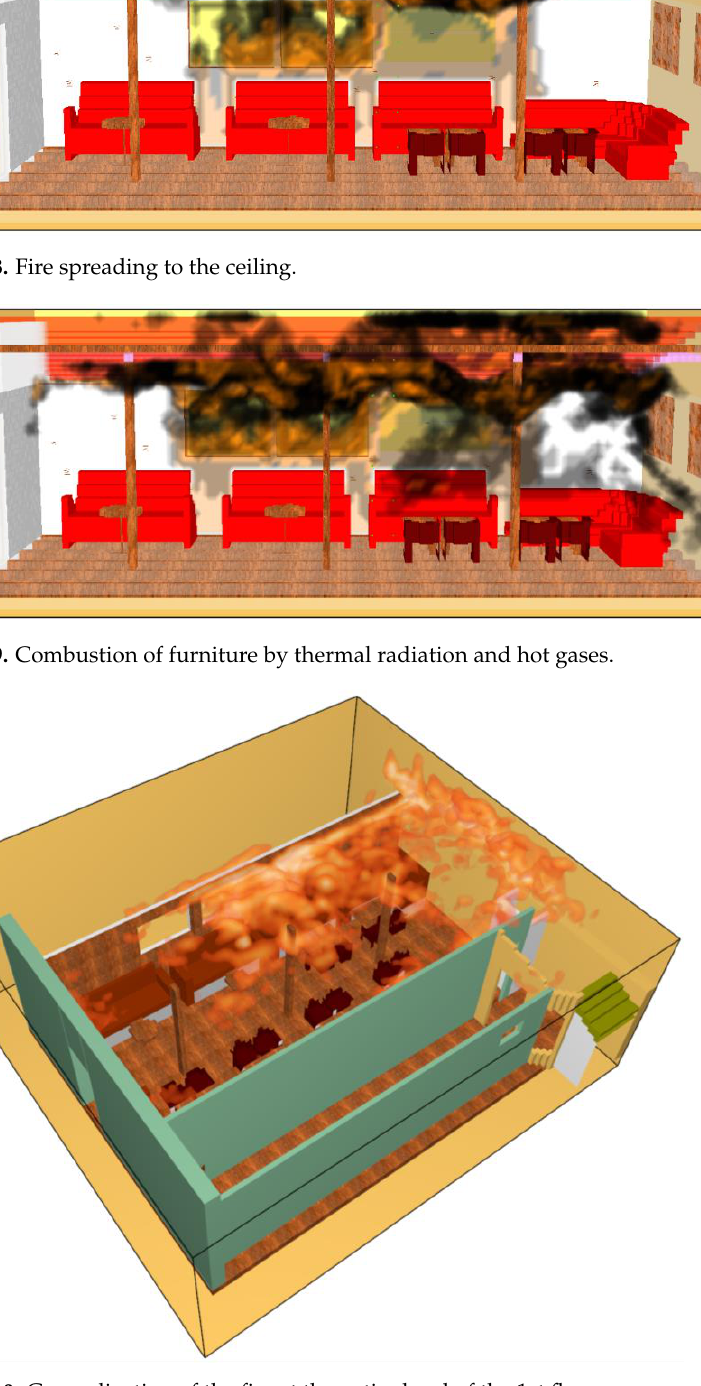
Figure 10. Generalization of the fire at the entire level of the 1st floor.